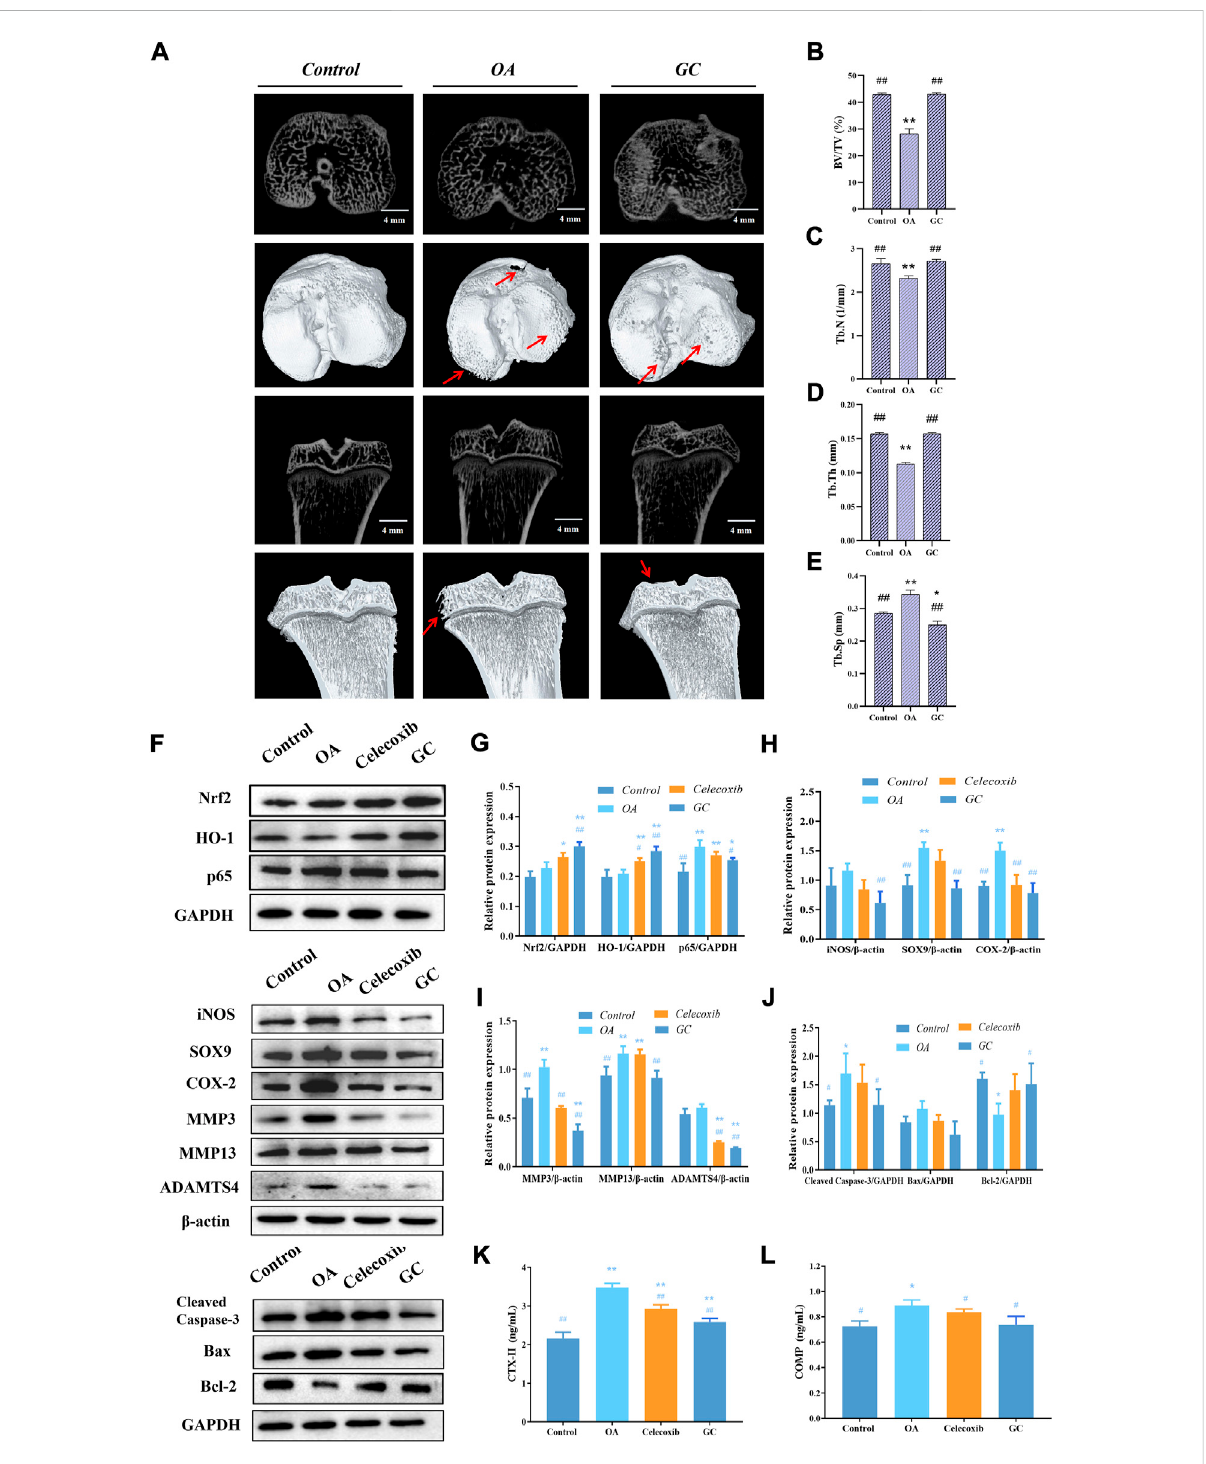
FIGURE 6 GC regulates Nrf2/HO-1 and NF- κ B pathways to rescue joint degeneration in OA rats in vivo . (A) Microcomputed tomography analysis of proximaltibiasfromthreegroupsasfollows:control,OA,GC(10 mg/kgbodyweight).Thedamagedregionofthearticularsurfaceisindicatedbyred arrows. 4 mm scale bar. (B) Quantitative results of the structural parameters of the tibial subchondral bone, including bone volume/tissue volume (BV/TV), (C) trabecularnumber(Tb.N), (D) trabecularthickness(Tb.Th),and (E) trabecularseparation(Tb.Sp). (F – J) WesternblotanalysisofNrf2/ HO-1 and NF- κ B pathway related proteins expression in rat cartilage. (K – L) Effects of GC on the levels of biomarkers CTX-II and COMP in serum of PTOA rats. All data are presented as mean ± SD (n = 3). * p < 0.05 and ** p < 0.01 vs. control group; # p < 0.05 and ## p < 0.01 vs. OA